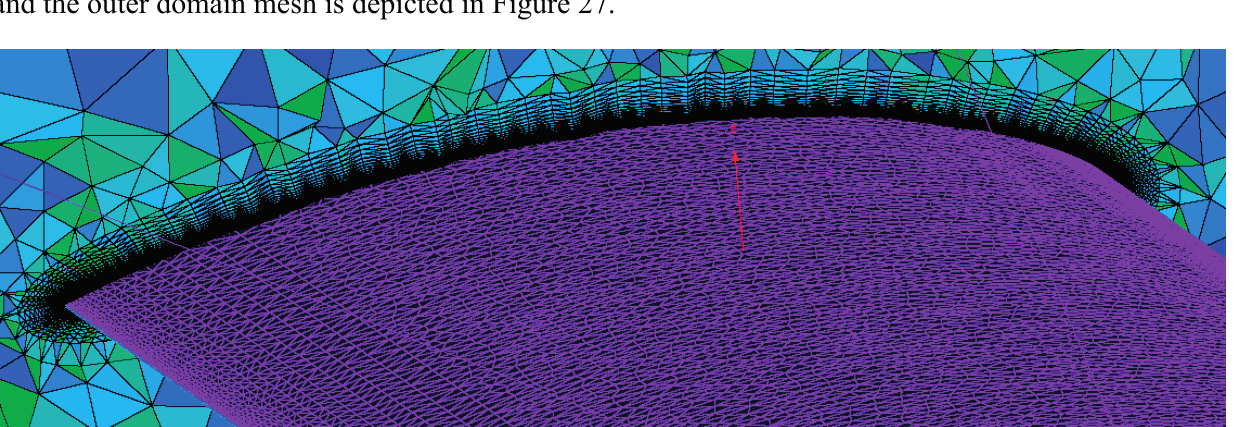
Figure 26. Generated boundary layer mesh over the wing